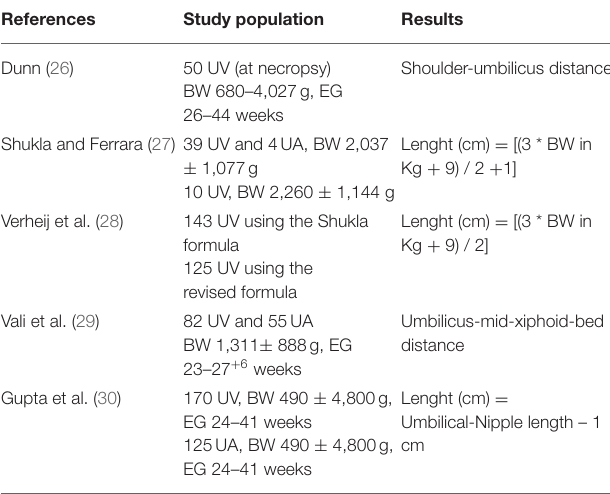
TABLE 1 | Different methods to estimate a correct UVC insertion length.